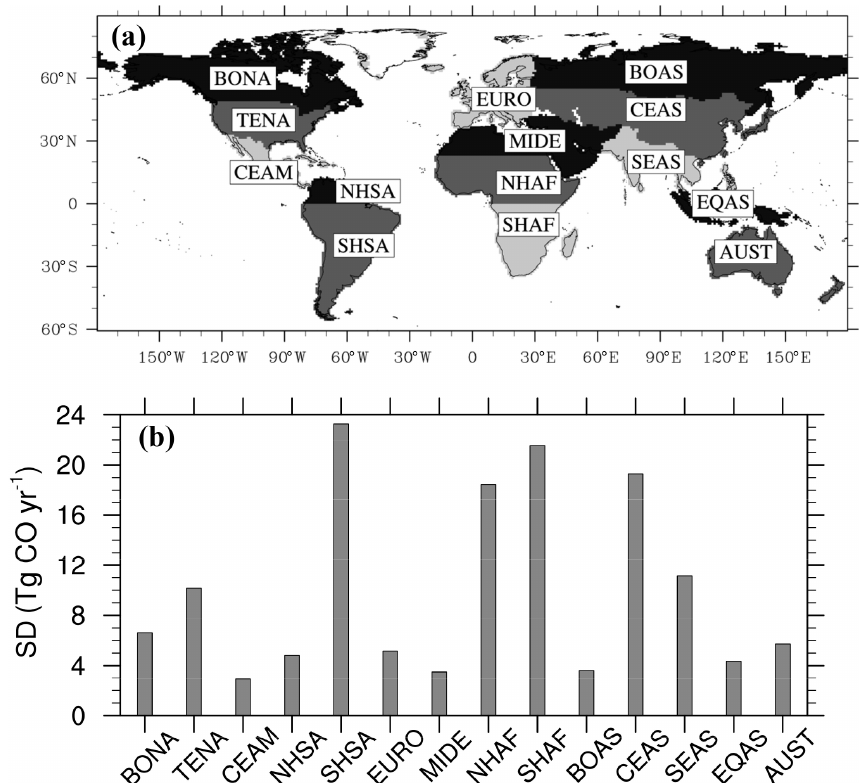
Figure 8. (a) GFED region definition (http://www.globalfiredata.org/data.html, last access: 2 October 2018) and (b) inter-model discrepancy (quantified using inter-model standard deviation) in long-term changes (a 21-year running mean is used, relative to the present day) of sim- ulated regional fire CO emissions (TgCOyr − 1 ) averaged over 1700–2012 (calculate long-term changes relative to the present day for each FireMIP model first, then the inter-model standard deviation, and lastly the time average). The abbreviations are BONA: boreal North Amer- ica; TENA: temperate North America; CEAM: central America; NHSA: Northern Hemisphere South America; SHSA: Southern Hemisphere South America; EURO: Europe; MIDE: Middle East; NHAF: Northern Hemisphere Africa; SHAF: Southern Hemisphere Africa; BOAS: boreal Asia; CEAS: central Asia; SEAS: Southeast Asia; EQAS: equatorial Asia; AUST: